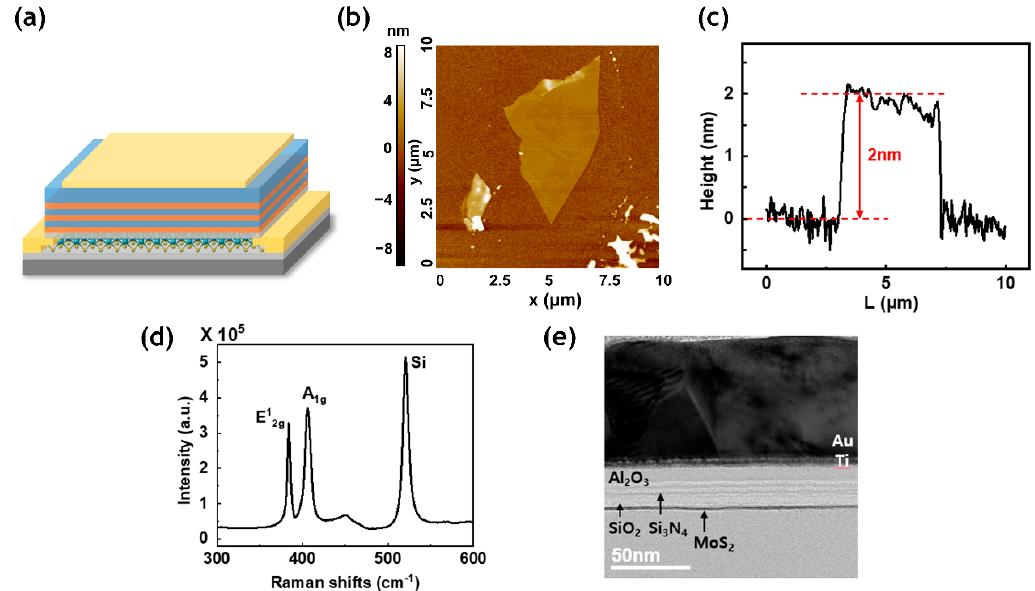
Figure 1. ( a ) Schematic of the CTF memory device with multilayered charge trapping structure. ( b , c ) AFM scan image and height profile of the MoS 2 flake. ( d ) Raman spectra of MoS 2 peaks; 𝐸 (cid:2870)(cid:3034)(cid:2869) at 384 cm − 1 and A 1g at 406 cm − 1 . ( e ) Cross-sectional TEM image of the device.